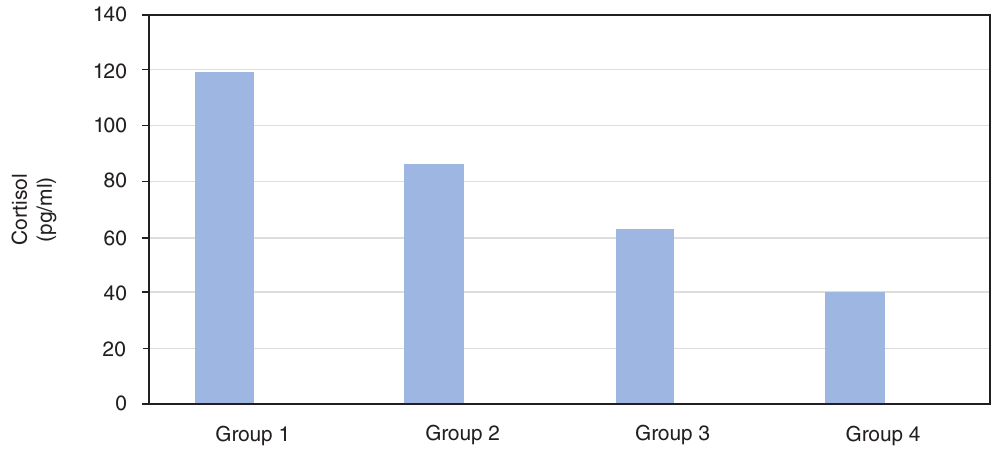
Figure 2. Effect of red-fleshed pitaya extract on cortisol in rats that were given strenuous